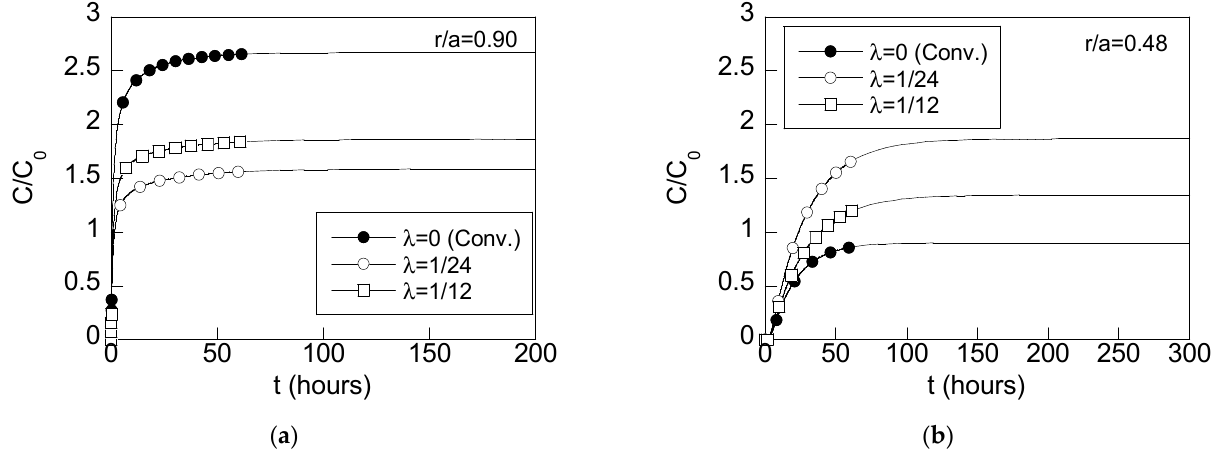
Figure 11. Time evolution of hydrogen concentration for wires drawn with optimal skin pass dies (blank symbols) and with conventional dies (filled circles) at: ( a ) prospective damage zone, r / a = 0.90 and ( b ) inner points, r / a = 0.48.